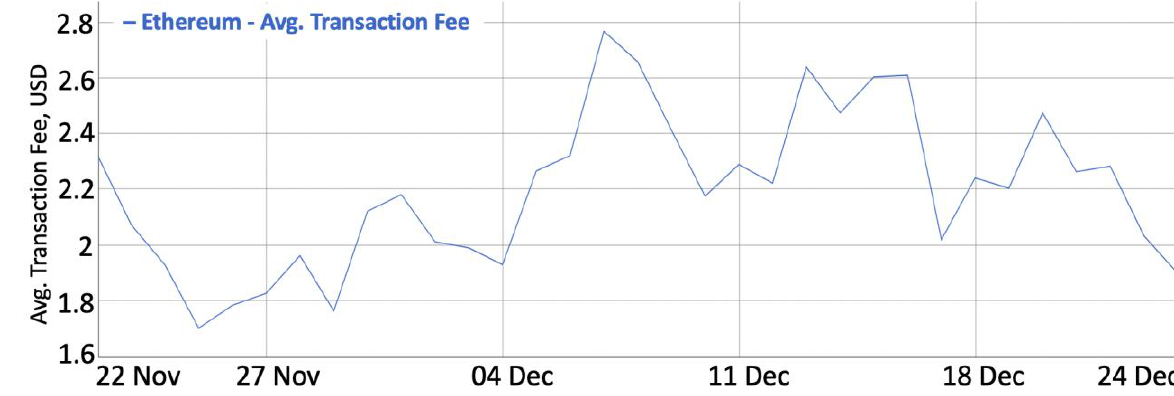
Figure 15. Average daily transaction fee of Ethereum blockchain from 22 November 2022 to 24 December 2022 https://blockchair.com/ethereum/charts/average-transaction-fee-usd (accessed on 15 January 2023).